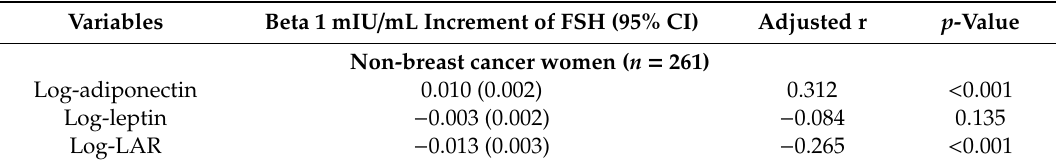
Table 2. Associations between FSH and adipocyte-derived hormones in the postmenopausal groups.